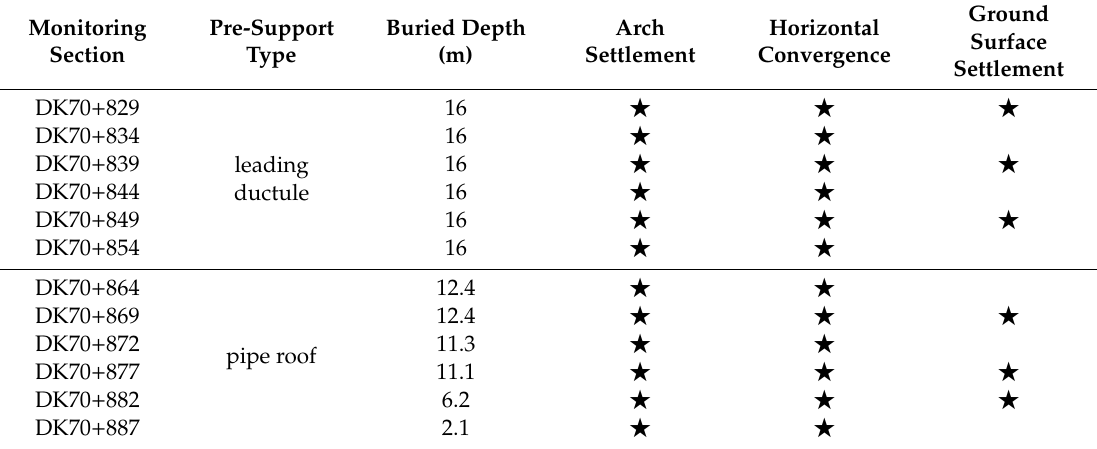
Table 3. Monitoring procedures of each